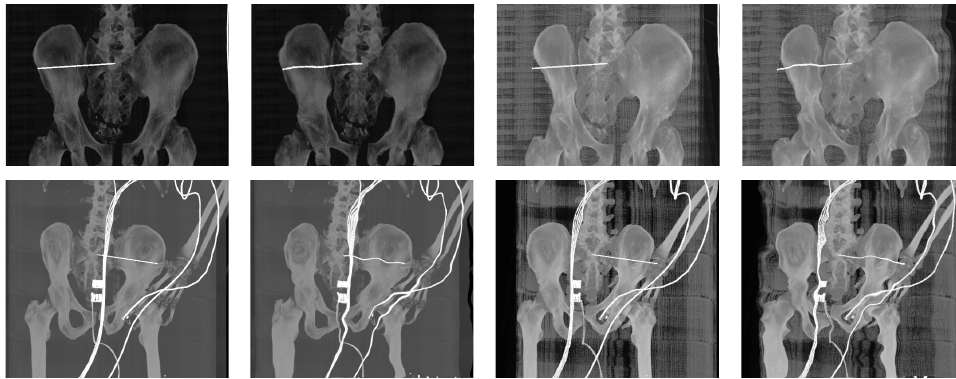
Figure 13. Best registered DRR projections with and without histogram matching. ( Top Row ) is Patient 1, ( Bottom Row ) is Patient